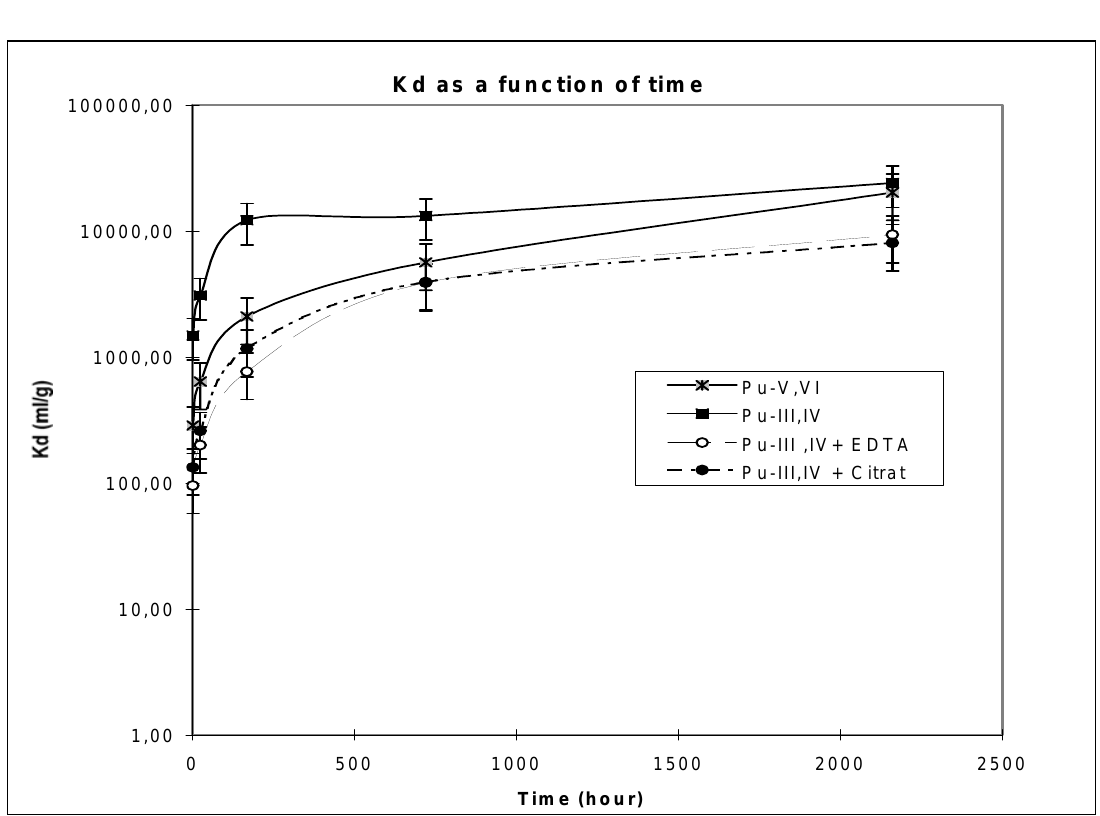
K d as a function of tim e